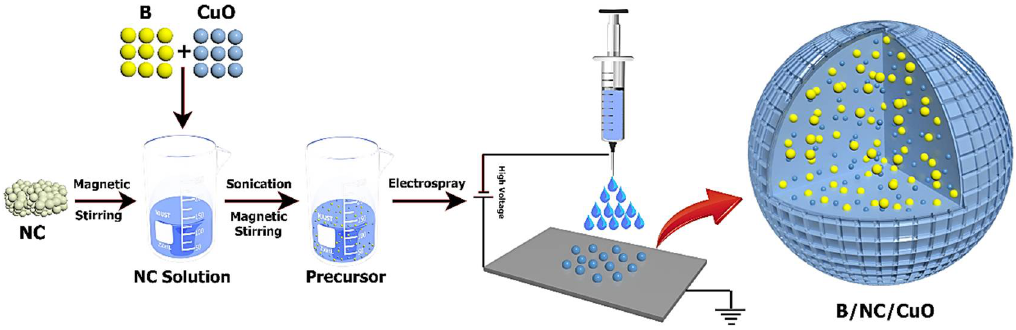
Figure 1. Schematic representation of the electrospray technique for the preparation of B/NC/CuO.